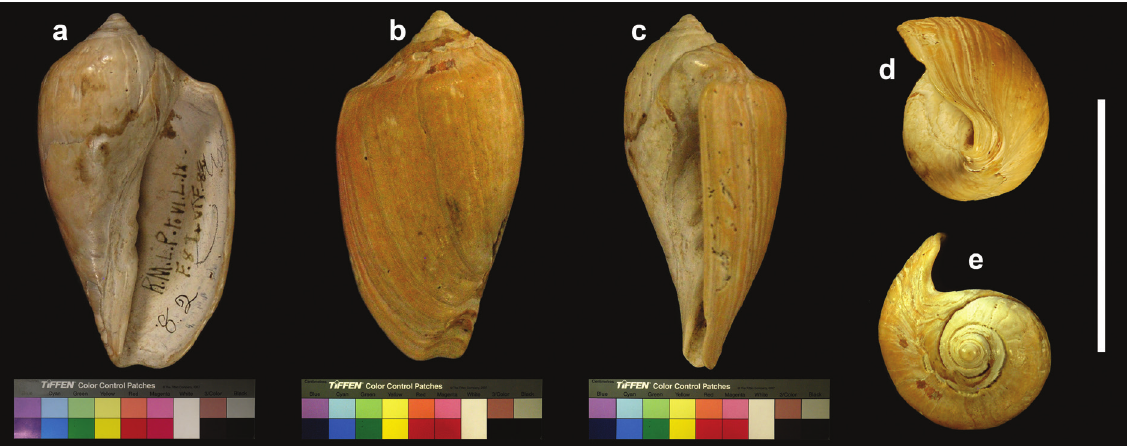
Figure 22. Voluta angulata mixta , specimen figured by Lahille (1895: pl. IX, fig. 8; pl. VI, fig. 82). a Apertural view b Dorsal view c Lateral view d Umbilical view e Apical view. Scale bar: 5